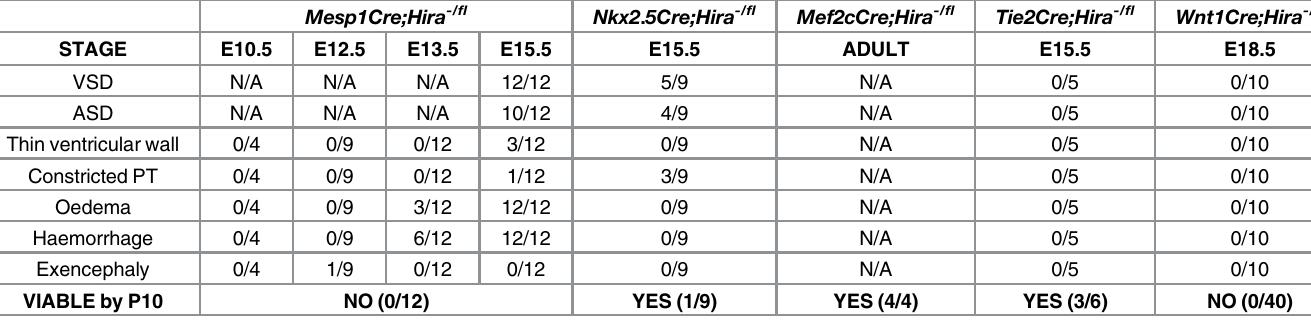
Table 1. Embryonic phenotype resulting from the conditional ablation of Hira .